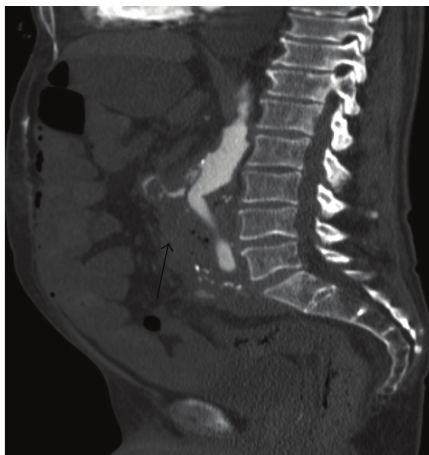
Figure 2: Sagittal contrast-enhanced CT scan of AEF.